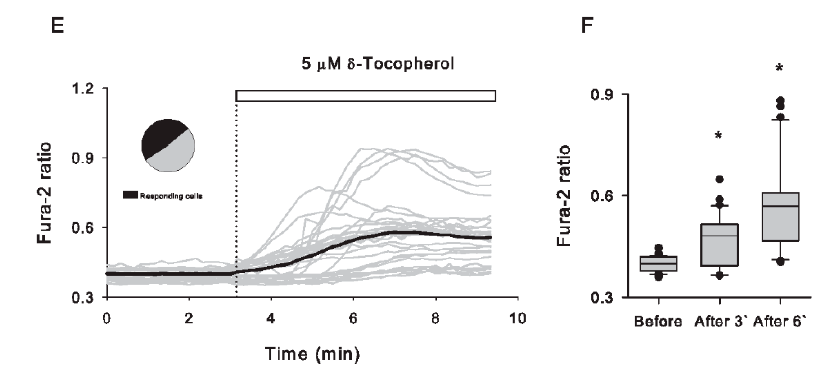
Figure 1. α -, γ - and δ -tocopherol isomers induce acute cytosolic Ca 2 + increases with di ff erent patterns in Caco-2 cells. ( A ) Time course of Fura-2 fluorescence ratio in Caco-2 cells; grey traces in the graph correspond to 78 single-cell recordings from three independent experiments, whereas the black line depicts their average. The moment of 5 µ M α -tocopherol addition is indicated by a dotted line and by the white bar on the plot. The pie chart illustrates the proportion of responding cells in black. ( B ) Quantification of fluorescence ratio values taken from a 3 min bin before and after the addition of α -tocopherol (3 and 6 min); the line into the boxes corresponds to the median, black symbols ( • ) correspond to potential outliers. ( C ) Same as in ( A ), but in this graph the e ff ect of 5 µ M γ -tocopherol is shown by 79 single-cell recordings from four independent experiments in grey traces, whereas the black line represents the average of these responses. The pie chart illustrates the proportion of responding cells in black. ( D ) Comparison of Fura-2 ratio values obtained as described for ( B ). ( E ) Same as described in ( A ) and ( C ), but this graph shows the e ff ect of 5 µ M δ -tocopherol obtained from 31 single-cell recordings of five independent experiments. The pie chart illustrates the proportion of responding cells in black. ( F ) Analysis of fluorescence ratio values obtained before and after application of this isomer as described in ( B ) and ( D ). Asterisks (*) indicate significant di ff erences obtained by paired Student’s t